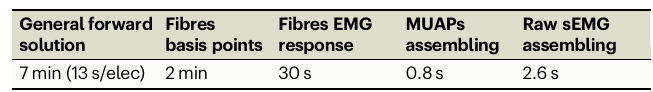
Table 1 | Computational performance of each of the main steps of a raw EMG